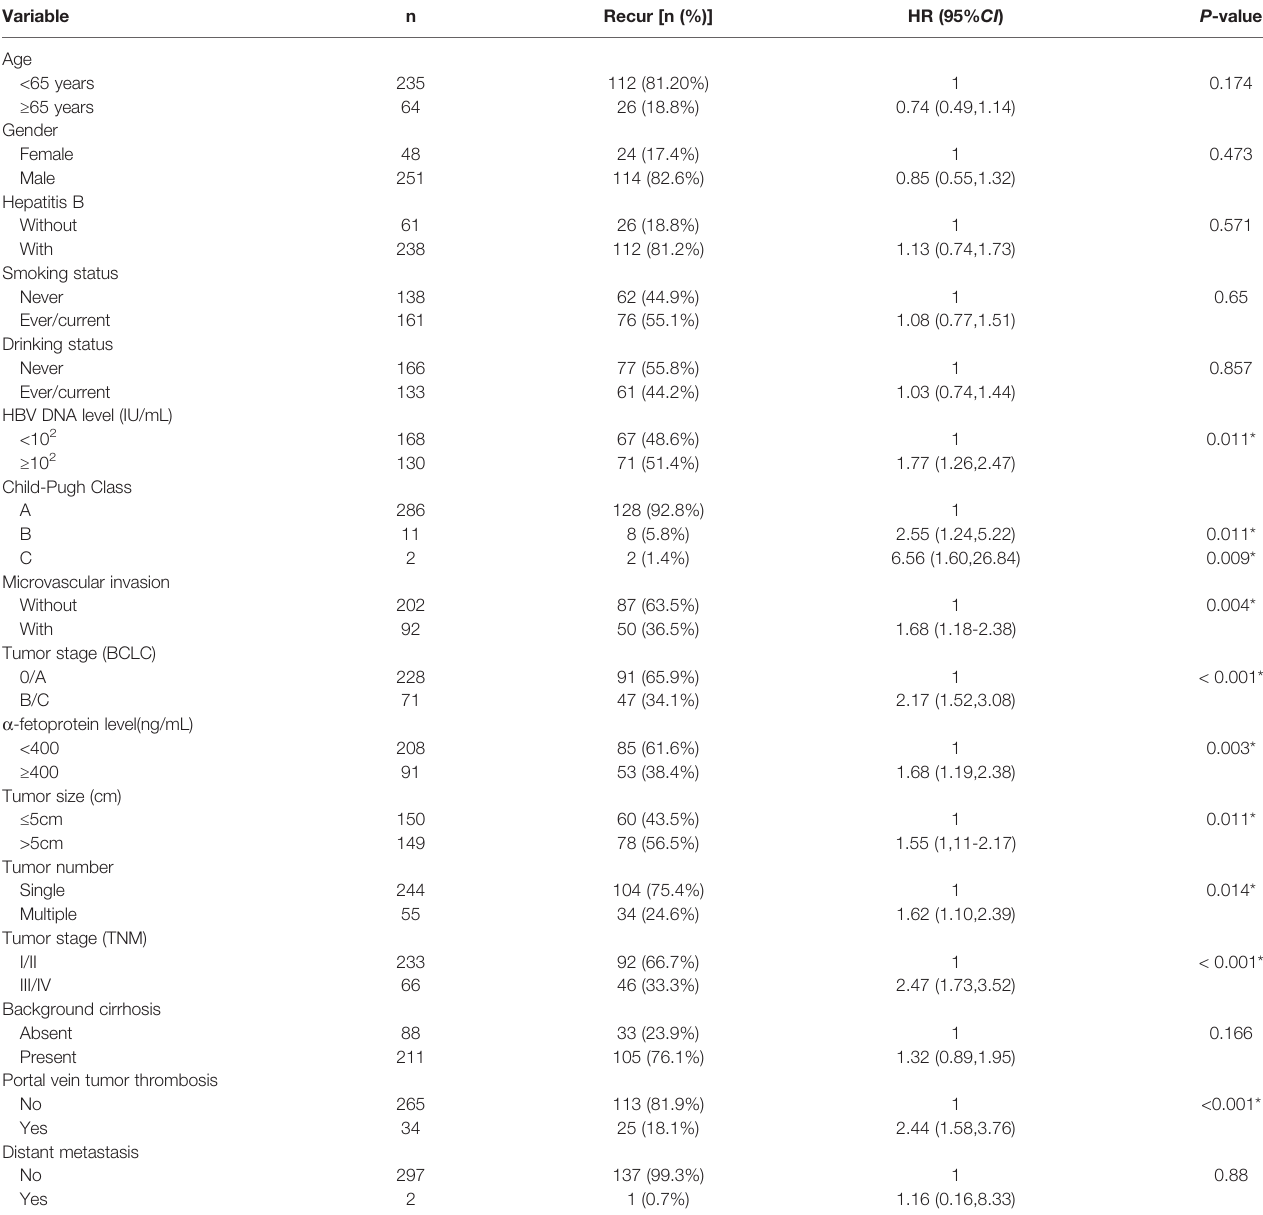
TABLE 3 | Univariate survival analysis of clinical factors associated with HCC recurrence.